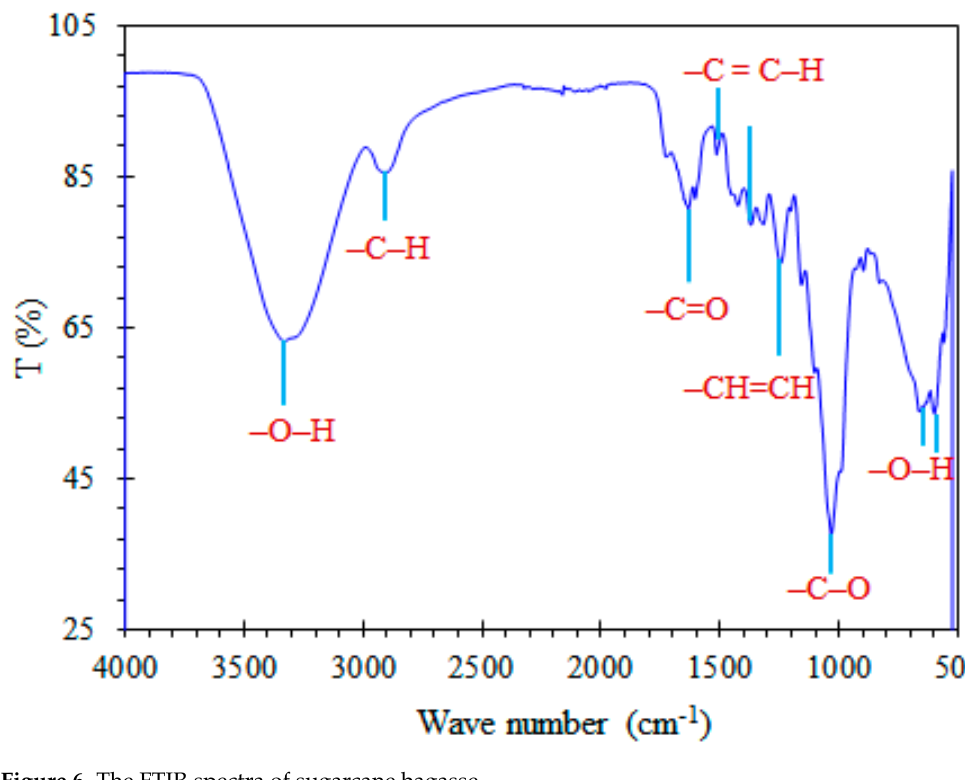
of no-adsorbed molecules, q m and K L are constants of the Langmuir model, and K F and n are con- stants of Freundlich isotherm model. Figure 6. The FTIR spectra of sugarcane bagasse. Figure 6. The FTIR spectra of sugarcane bagasse.